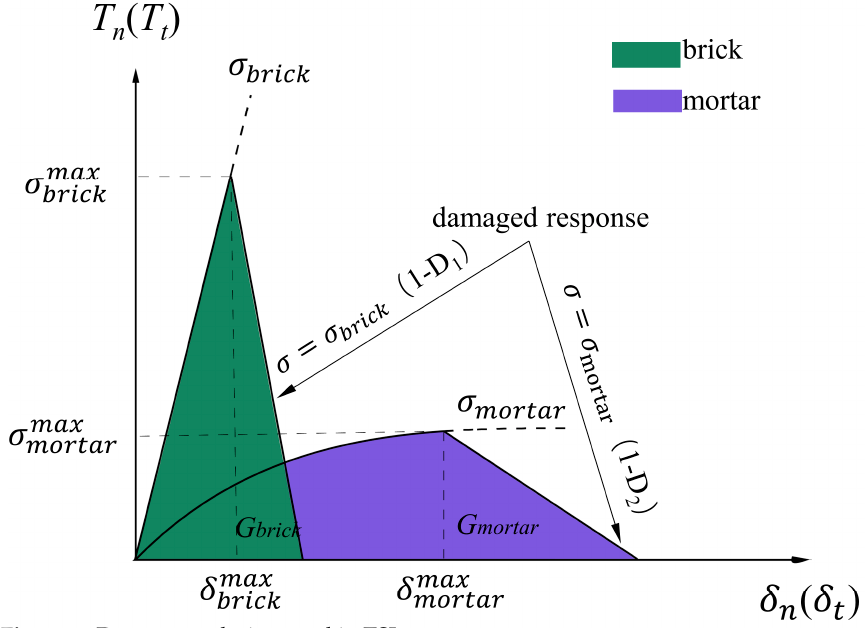
Figure 1. Damage evolution used in TSL.